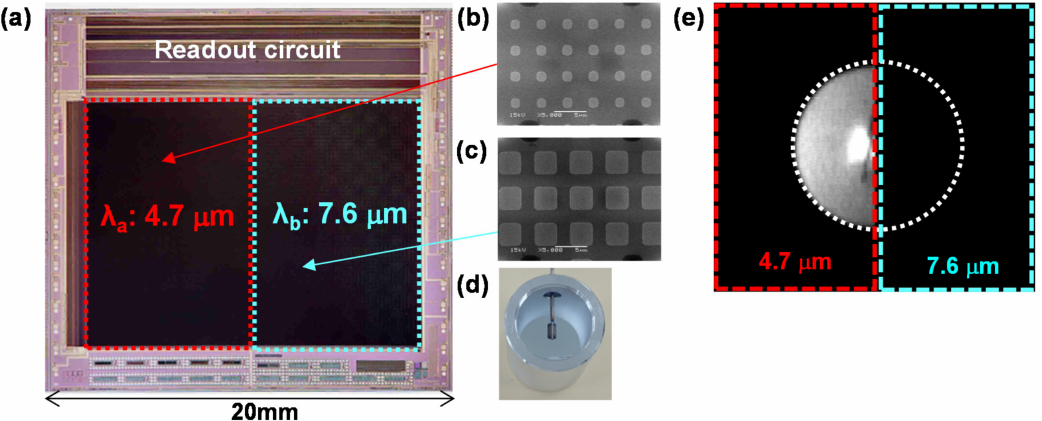
Figure 7. ( a ) Optical microscopy image of the developed image sensor with two TH MIM-PMAs. SEM images of MIM-PMAs integrated in the ( b ) left and ( c ) right halves of the pixel array; ( d ) Optical image of the light emitter used in the image; ( e ) Image of the light emitter obtained using the developed image sensor with the narrow bandpass filter centered at 4.7 µ